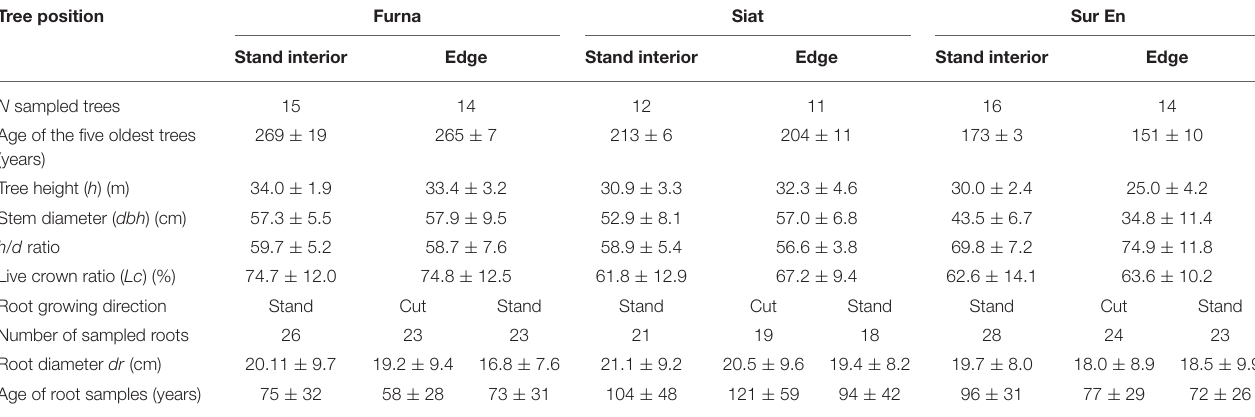
TABLE 2 | Characteristics of the sampled trees (stems and roots) in summer 2017. Tree position Furna Siat Sur En Stand interior Edge Stand interior Edge Stand interior